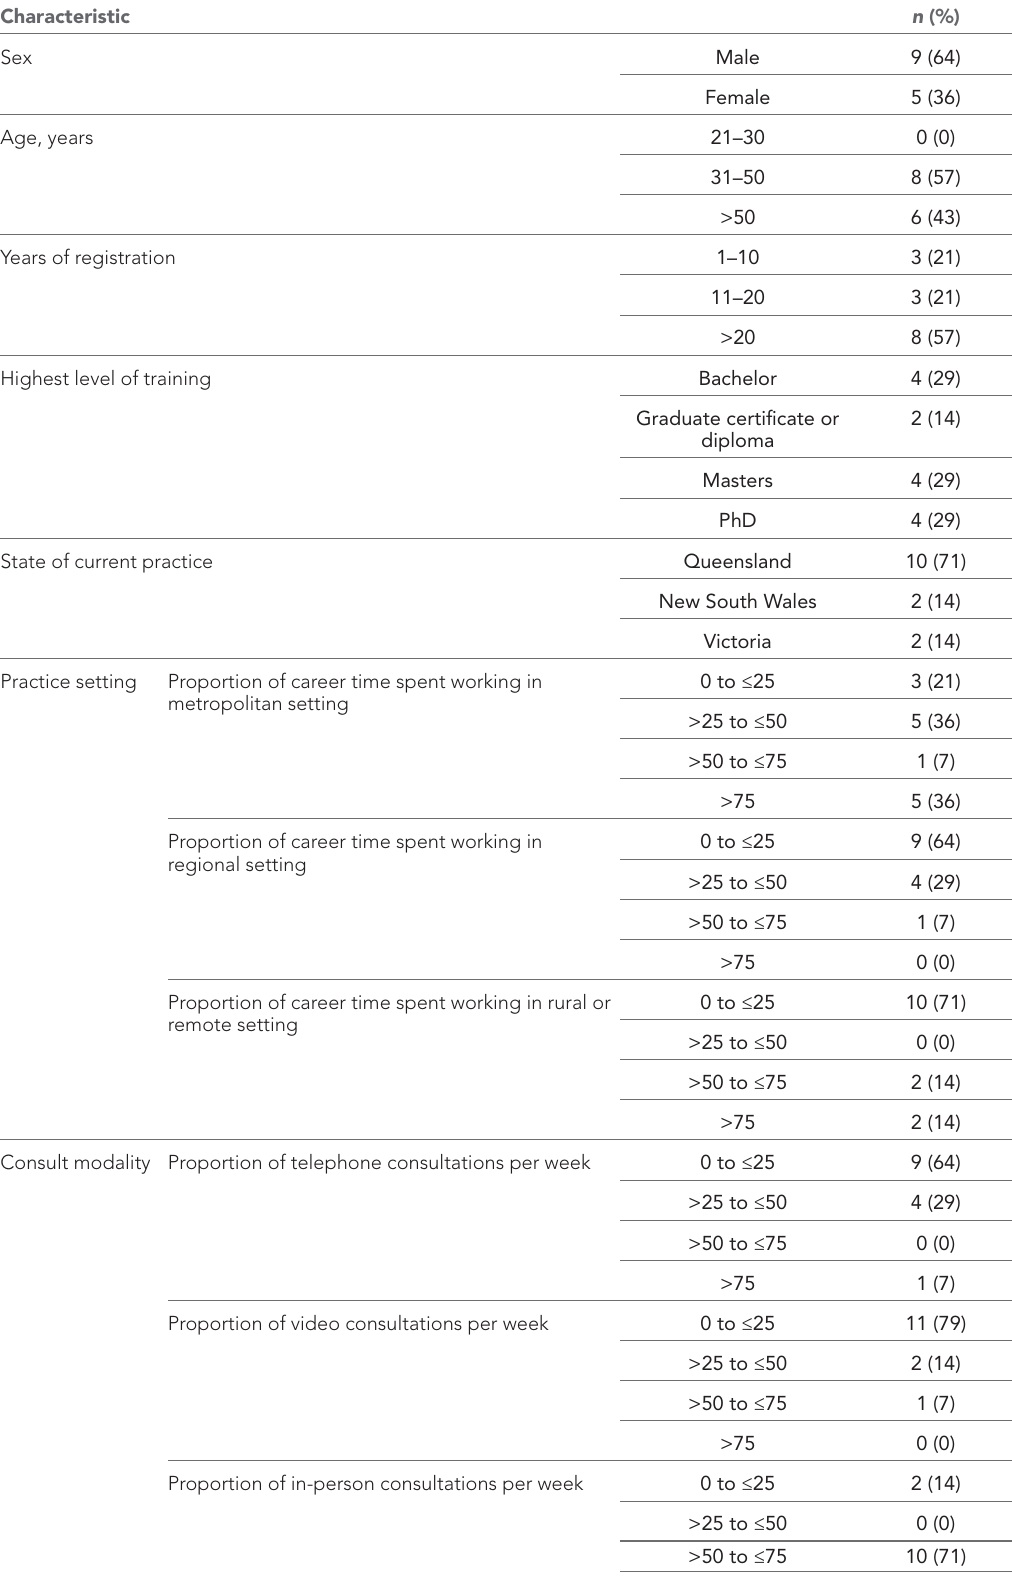
Table 1 Participant demographic